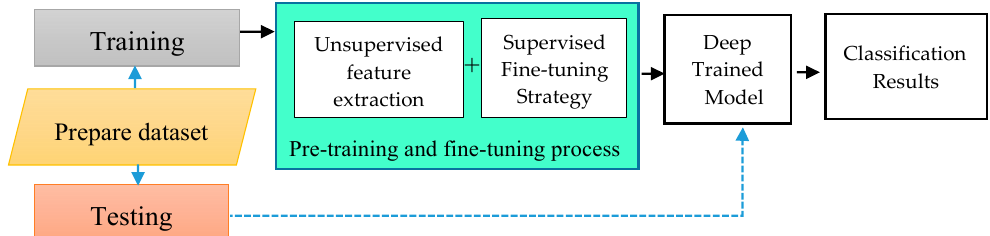
Figure 7. Flowchart showing the procedure used to validate the model. The deep trained model was tested on unseen data.